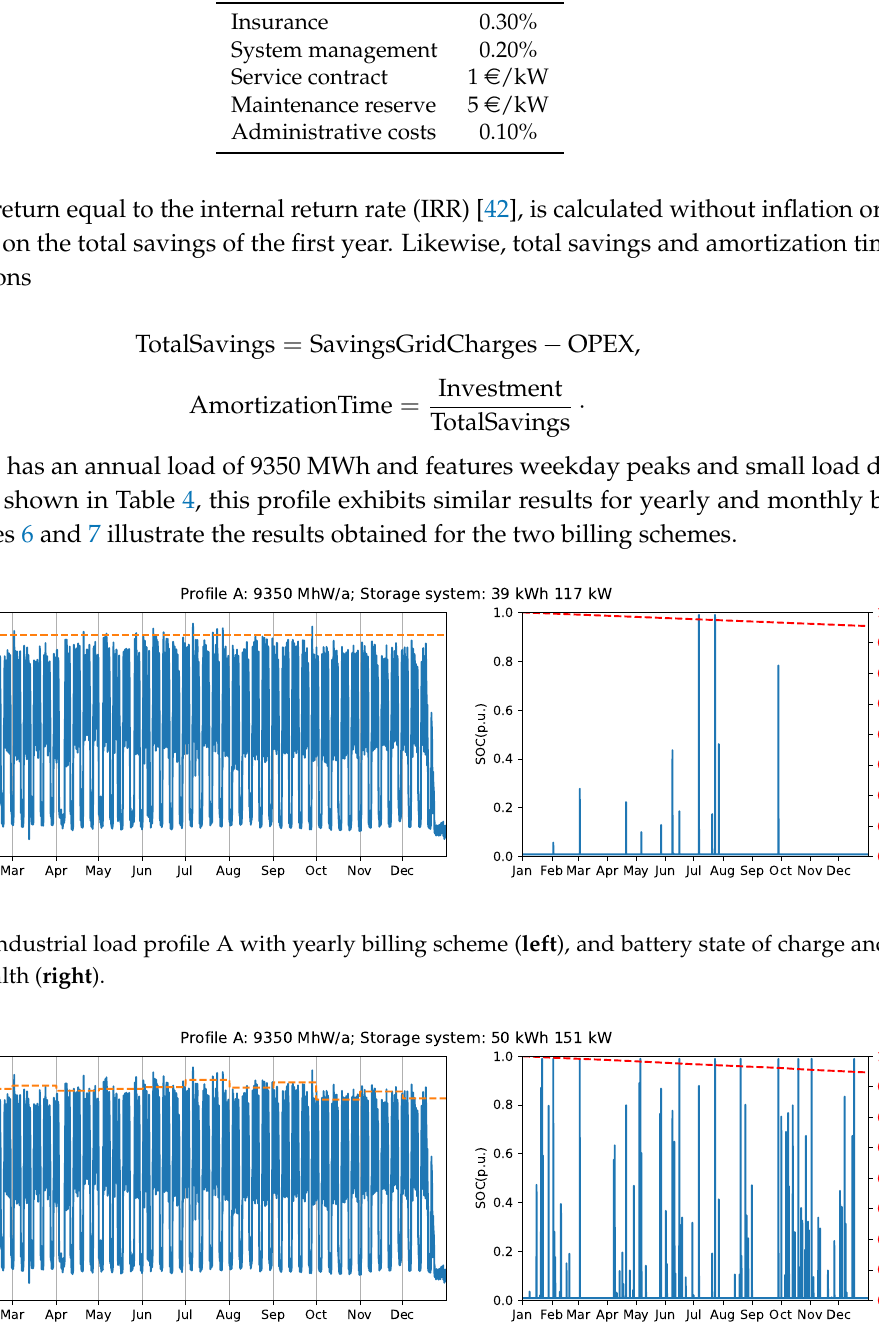
Table 5. Operation cost (OPEX) composition.